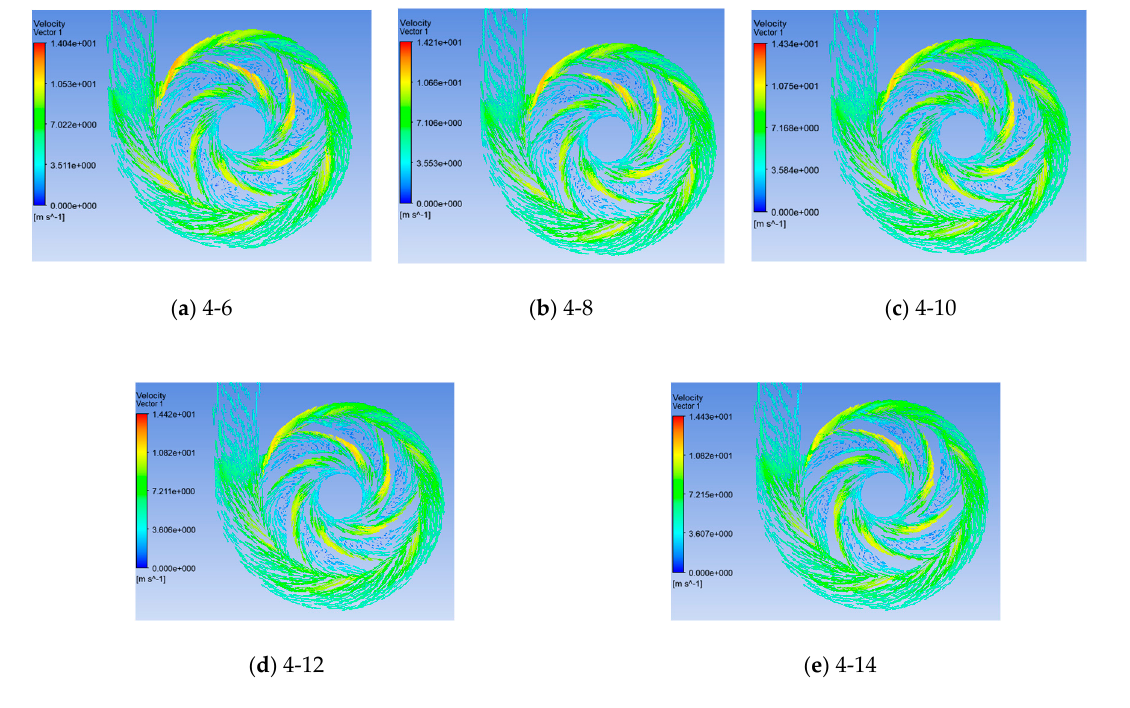
Figure 11. Velocity distribution of VTB.